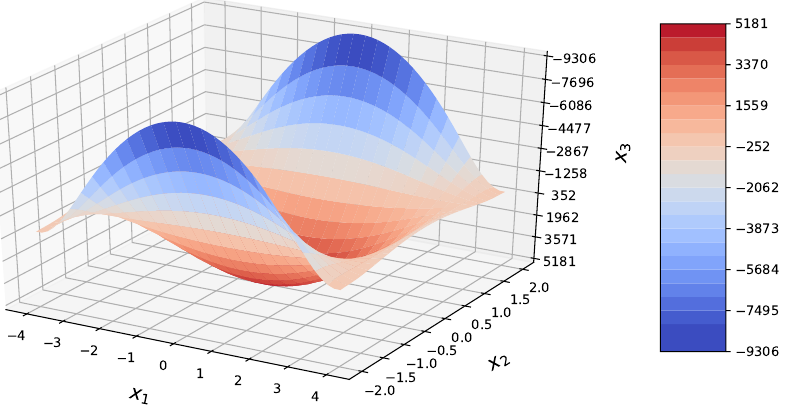
Figure 22. Three-dimensional plot of the bending moment M 22 of a rectangular plate with clamped edges.